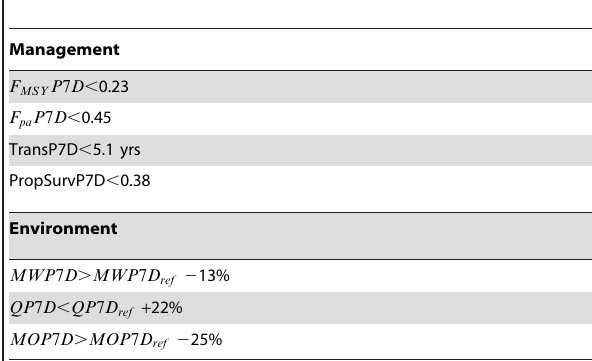
Table 11. Management parameters values identified from leaf 4 and environmental variability they allow dealing with. For plaice in subarea